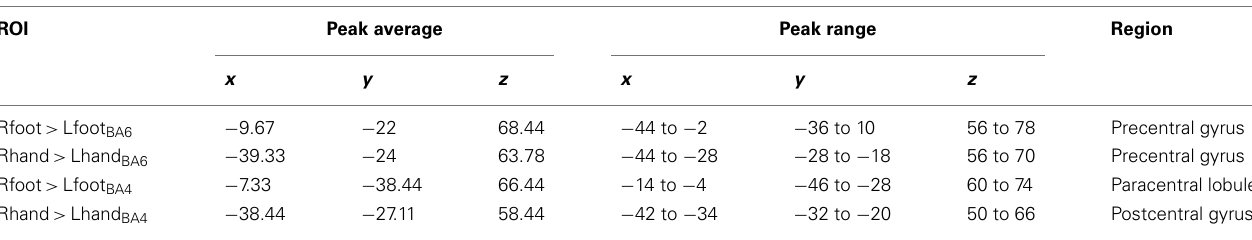
Table 3 | Mean peak coordinates localizer